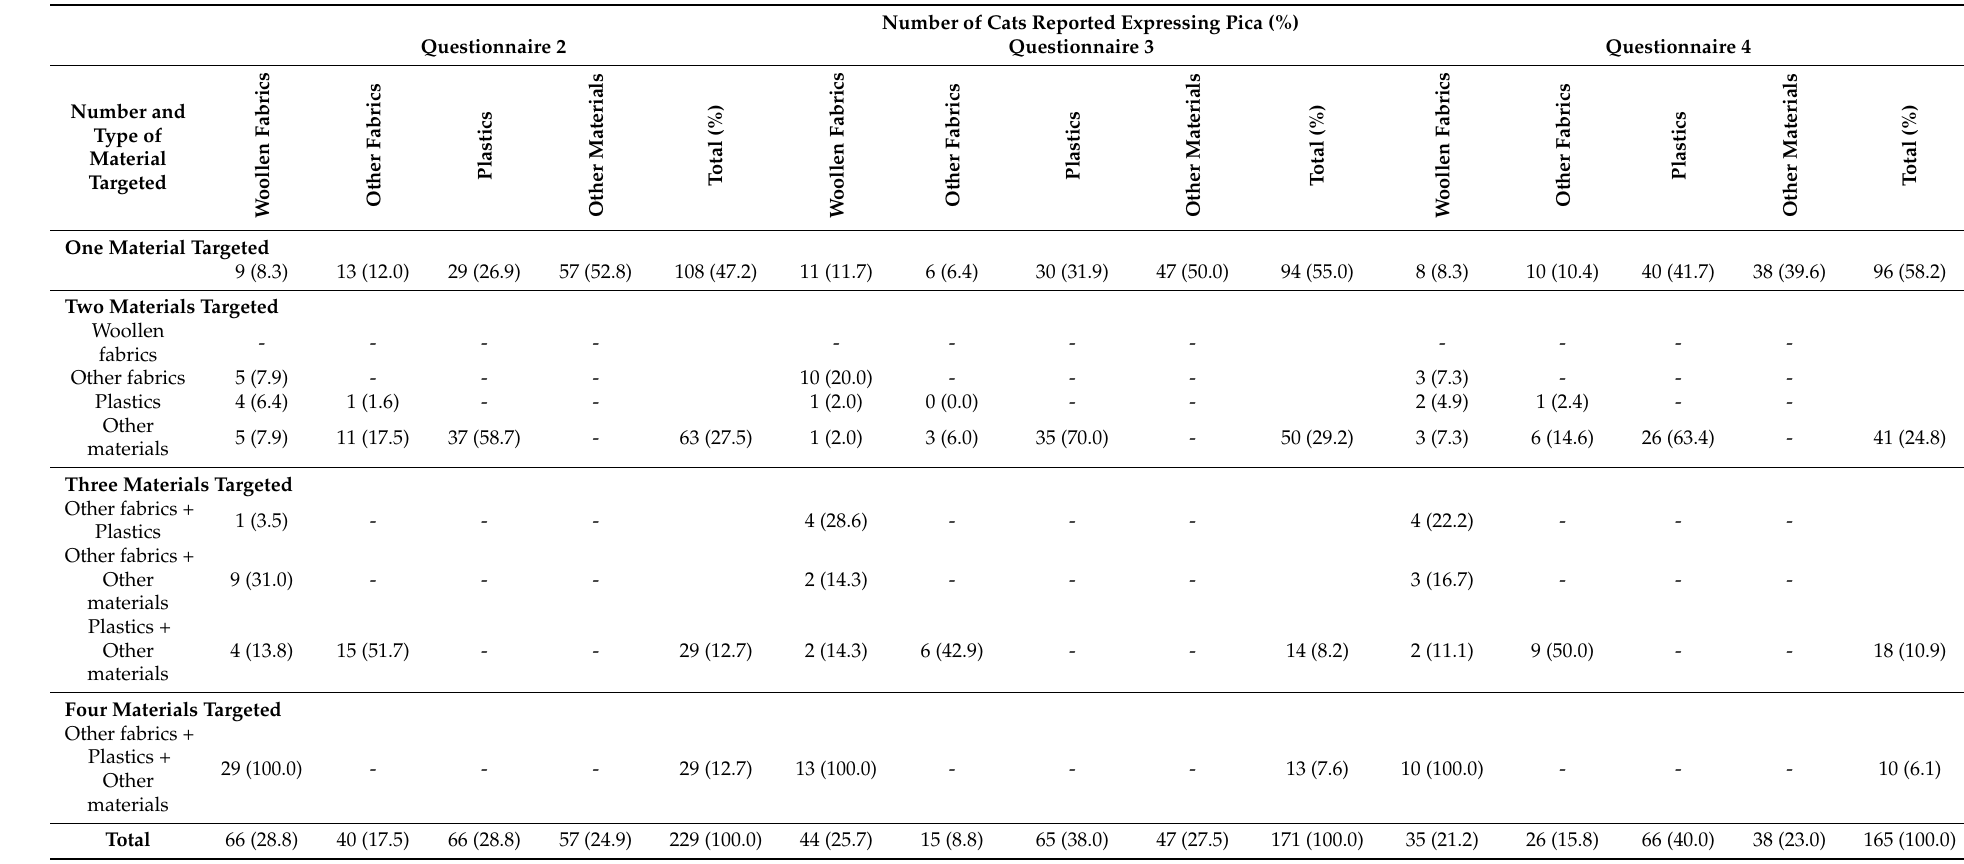
Table 4. Co-occurrence of pica exhibited by 229, 171, and 165 cats who targeted one or more material types as reported in Questionnaire 2 (when cats were aged 6.5–7 months), Questionnaire 3 (when cats were aged 12.5–13 months) and Questionnaire 4 (when cats were aged 18.5–19